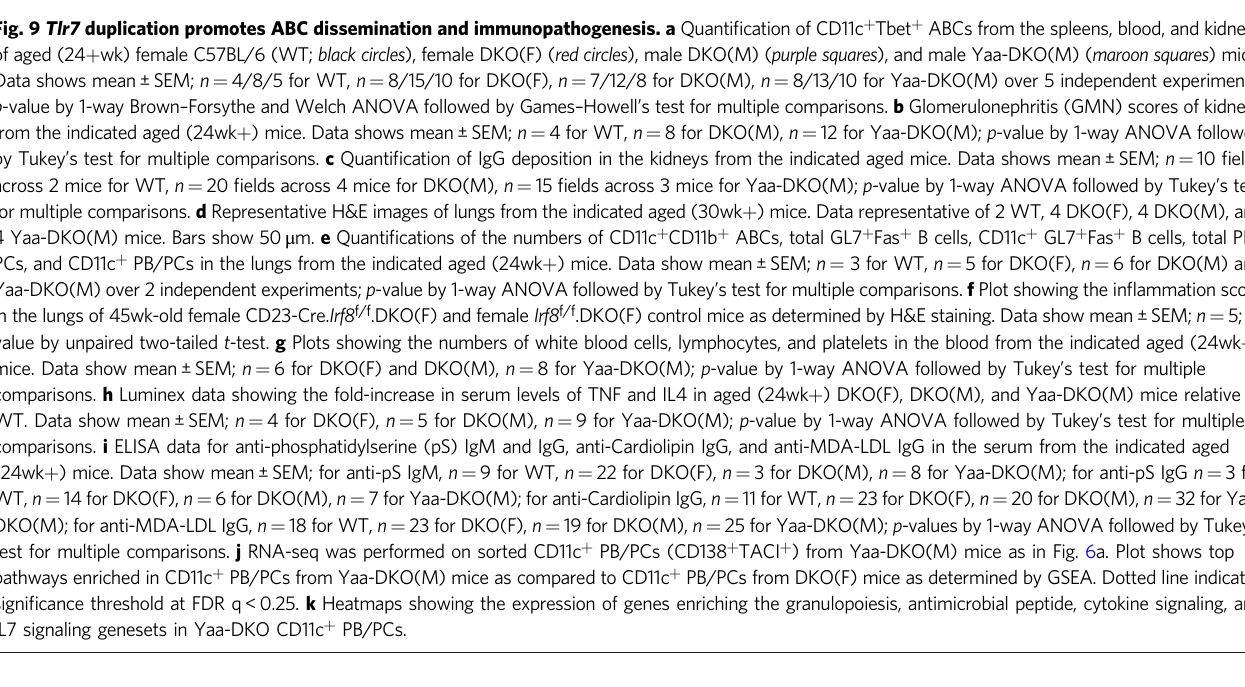
Fig. 9 Tlr7 duplication promotes ABC dissemination and immunopathogenesis. a Quanti fi cation of CD11c + Tbet + ABCs from the spleens, blood, and kidneys of aged (24 + wk) female C57BL/6 (WT; black circles ), female DKO(F) ( red circles ), male DKO(M) ( purple squares ), and male Yaa-DKO(M) ( maroon squares ) mice. Data shows mean±SEM; n = 4/8/5 for WT, n = 8/15/10 for DKO(F), n = 7/12/8 for DKO(M), n = 8/13/10 for Yaa-DKO(M) over 5 independent experiments; p -value by 1-way Brown – Forsythe and Welch ANOVA followed by Games – Howell ’ s test for multiple comparisons. b Glomerulonephritis (GMN) scores of kidneys from the indicated aged (24wk + ) mice. Data shows mean±SEM; n = 4 for WT, n = 8 for DKO(M), n = 12 for Yaa-DKO(M); p -value by 1-way ANOVA followed by Tukey ’ s test for multiple comparisons. c Quanti fi cation of IgG deposition in the kidneys from the indicated aged mice. Data shows mean±SEM; n = 10 fi elds across 2 mice for WT, n = 20 fi elds across 4 mice for DKO(M), n = 15 fi elds across 3 mice for Yaa-DKO(M); p -value by 1-way ANOVA followed by Tukey ’ s test for multiple comparisons. d Representative H&E images of lungs from the indicated aged (30wk + ) mice. Data representative of 2 WT, 4 DKO(F), 4 DKO(M), and 4 Yaa-DKO(M) mice. Bars show 50 μ m. e Quanti fi cations of the numbers of CD11c + CD11b + ABCs, total GL7 + Fas + B cells, CD11c + GL7 + Fas + B cells, total PB/ PCs, and CD11c + PB/PCs in the lungs from the indicated aged (24wk + ) mice. Data show mean±SEM; n = 3 for WT, n = 5 for DKO(F), n = 6 for DKO(M) and Yaa-DKO(M) over 2 independent experiments; p -value by 1-way ANOVA followed by Tukey ’ s test for multiple comparisons. f Plot showing the in fl ammation score in the lungs of 45wk-old female CD23-Cre. Irf8 f/f .DKO(F) and female Irf8 f/f .DKO(F) control mice as determined by H&E staining. Data show mean±SEM; n = 5; p - value by unpaired two-tailed t -test. g Plots showing the numbers of white blood cells, lymphocytes, and platelets in the blood from the indicated aged (24wk + ) mice. Data show mean±SEM; n = 6 for DKO(F) and DKO(M), n = 8 for Yaa-DKO(M); p -value by 1-way ANOVA followed by Tukey ’ s test for multiple comparisons. h Luminex data showing the fold-increase in serum levels of TNF and IL4 in aged (24wk + ) DKO(F), DKO(M), and Yaa-DKO(M) mice relative to WT. Data show mean±SEM; n = 4 for DKO(F), n = 5 for DKO(M), n = 9 for Yaa-DKO(M); p -value by 1-way ANOVA followed by Tukey ’ s test for multiple comparisons. i ELISA data for anti-phosphatidylserine (pS) IgM and IgG, anti-Cardiolipin IgG, and anti-MDA-LDL IgG in the serum from the indicated aged (24wk + ) mice. Data show mean±SEM; for anti-pS IgM, n = 9 for WT, n = 22 for DKO(F), n = 3 for DKO(M), n = 8 for Yaa-DKO(M); for anti-pS IgG n = 3 for WT, n = 14 for DKO(F), n = 6 for DKO(M), n = 7 for Yaa-DKO(M); for anti-Cardiolipin IgG, n = 11 for WT, n = 23 for DKO(F), n = 20 for DKO(M), n = 32 for Yaa- DKO(M); for anti-MDA-LDL IgG, n = 18 for WT, n = 23 for DKO(F), n = 19 for DKO(M), n = 25 for Yaa-DKO(M); p -values by 1-way ANOVA followed by Tukey ’ s test for multiple comparisons. j RNA-seq was performed on sorted CD11c + PB/PCs (CD138 + TACI + ) from Yaa-DKO(M) mice as in Fig. 6a. Plot shows top pathways enriched in CD11c + PB/PCs from Yaa-DKO(M) mice as compared to CD11c + PB/PCs from DKO(F) mice as determined by GSEA. Dotted line indicates signi fi cance threshold at FDR q<0.25. k Heatmaps showing the expression of genes enriching the granulopoiesis, antimicrobial peptide, cytokine signaling, and IL7 signaling genesets in Yaa-DKO CD11c +